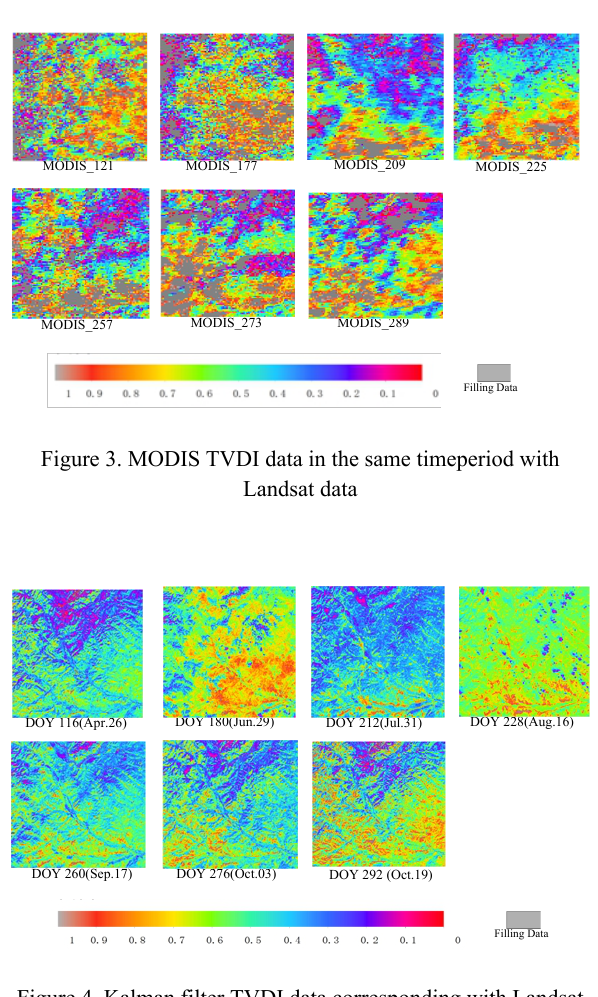
Figure 4. Kalman filter TVDI data corresponding with Landsat